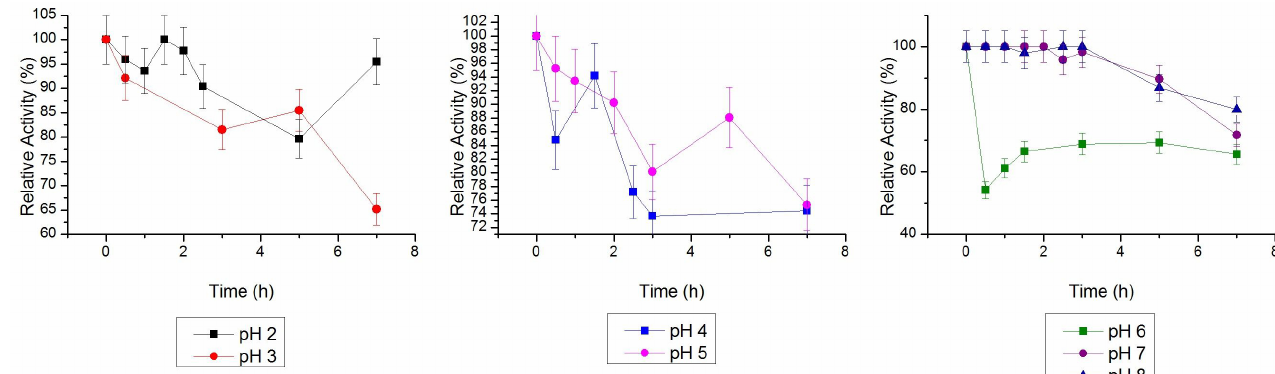
FIGURE 1 - Relative stability of bromelain in several pH at 20 °C. The error bars refer to standard deviation.